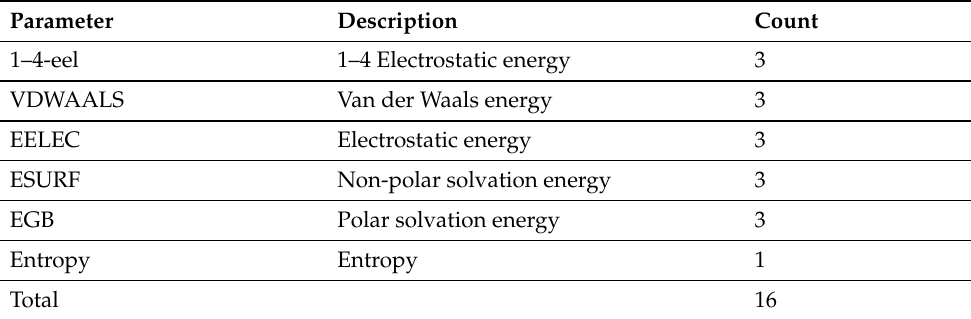
Table 1. Physics-based features calculated for complex, protein and ligand structures using GBNSR6.